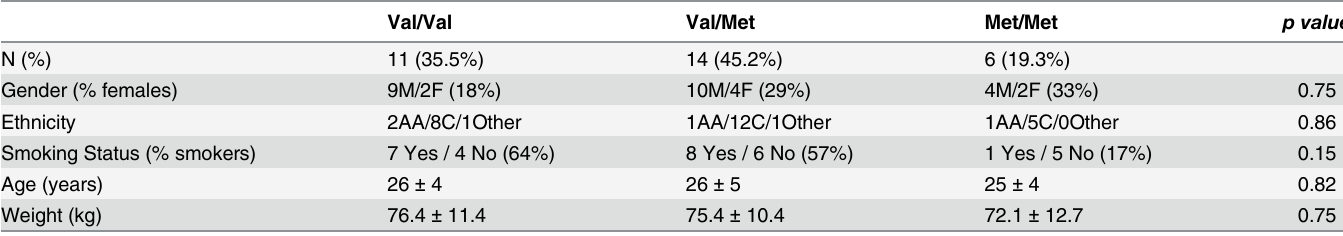
Table 1. Demographics of the clinical